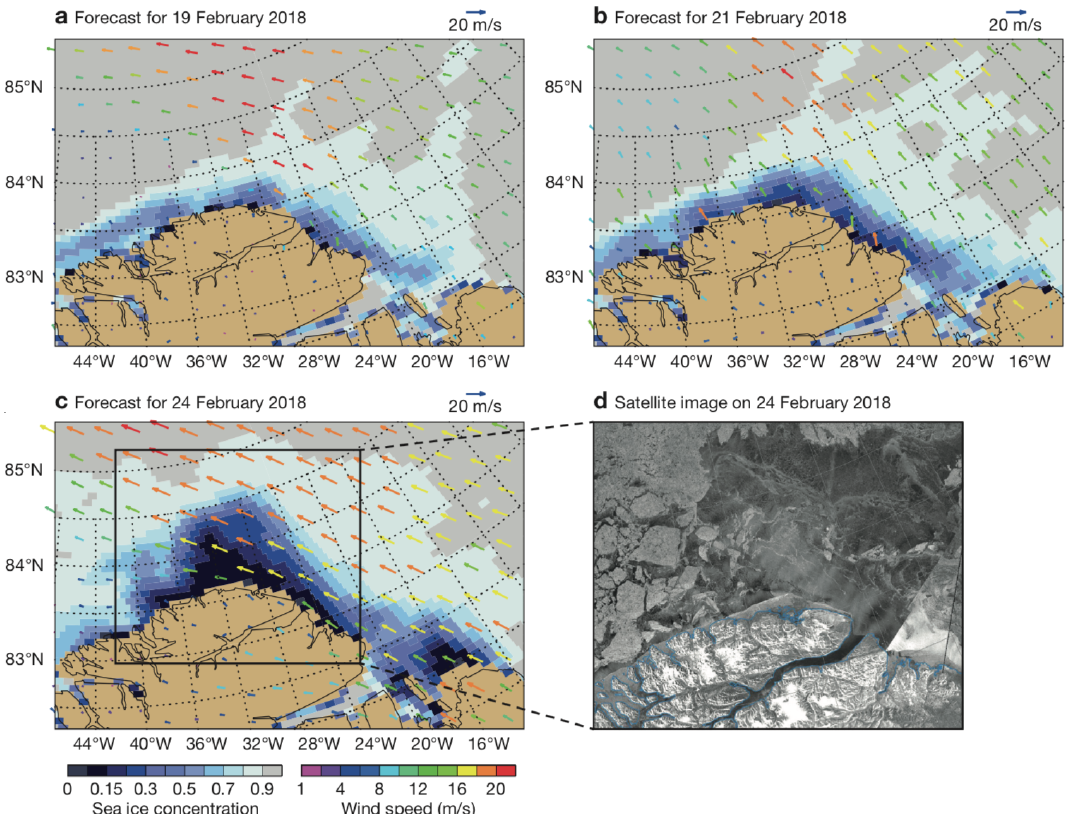
Figure 23. Evolution of sea ice concentration and the preceding 24-h mean 10-m wind field for forecasts initialised on 18 February 2018 and valid on ( a ) 19 February; ( b ) 21 February and ( c ) 24 February; ( d ) shows the Synthetic Aperture Radar (SAR) image from the Sentinel-1B satellite for 24 February around Cape Morris Jesup. (Satellite image: European Space Agency via Danish Meteorological Institute).